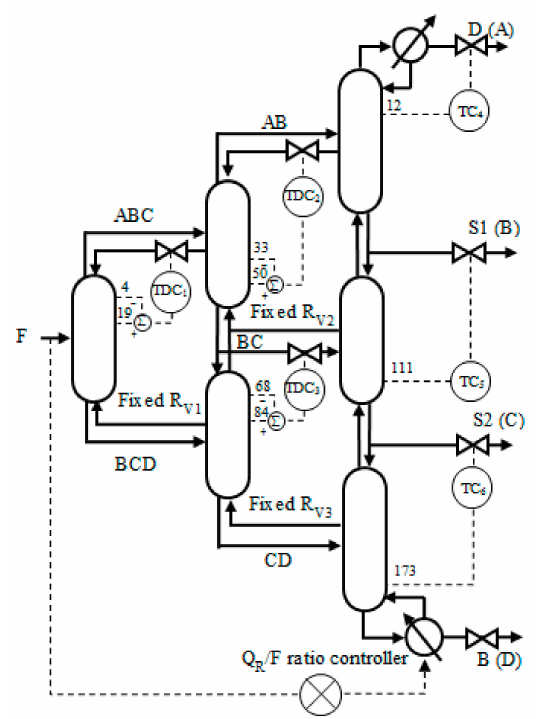
Figure 8. Simplified temperature di ff erence control scheme